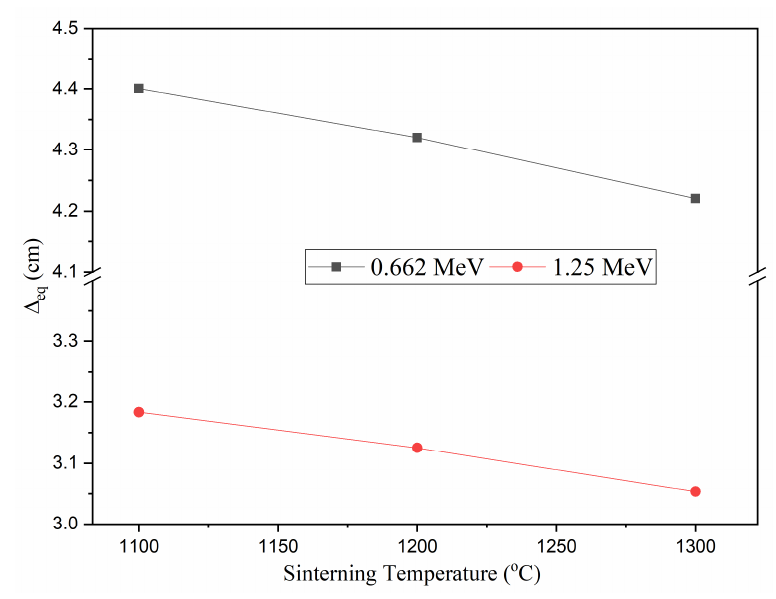
∆ eq , cm) values versus the sintering